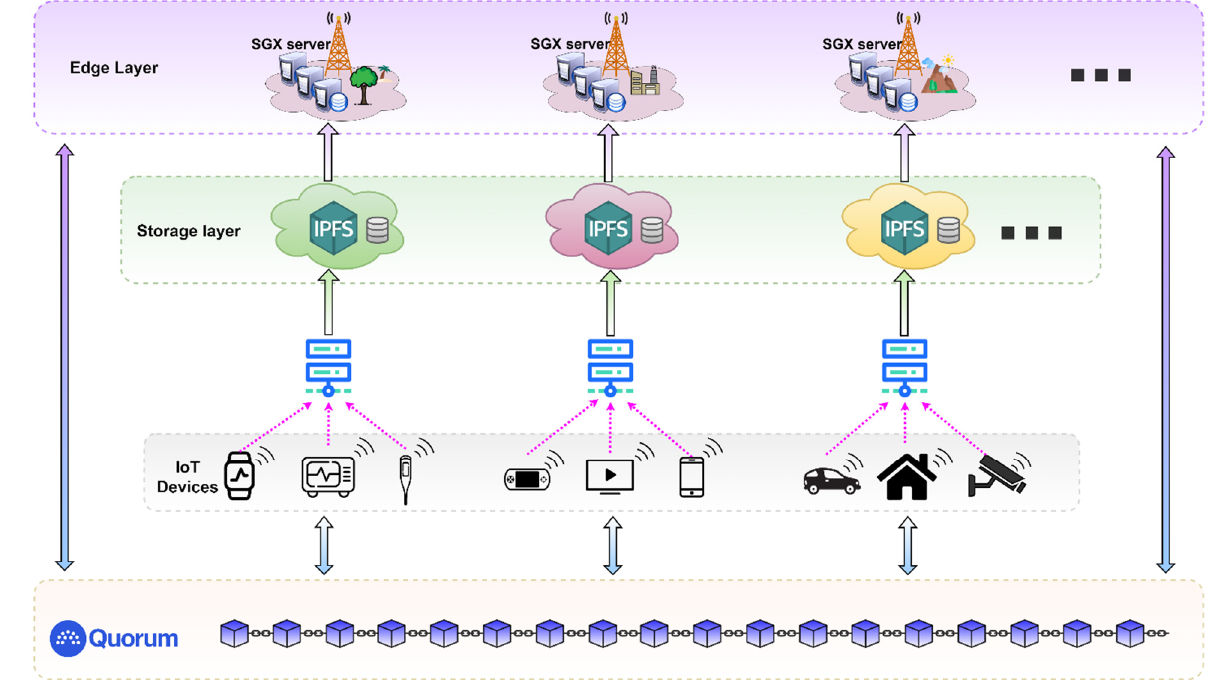
Figure 4. Overall view of components and layers of the system framework.